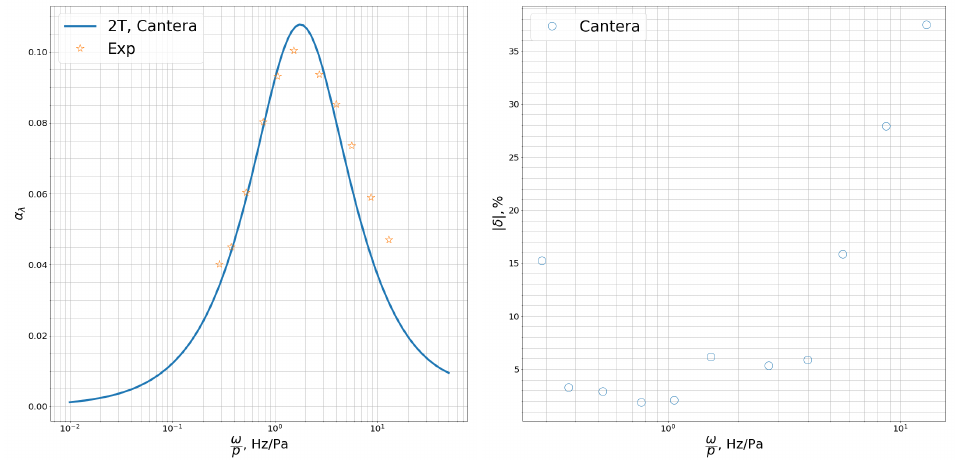
Figure 8. CO 2 -N 2 mixture. CO 2 (80%)–N 2 (20%), T = 294 ◦ C, p = 1 atm. Comparison with experi- ment [87]. ( Left ) dimensionless attenuation coefficient as a function of ω / p . ( Right ) deviation from the